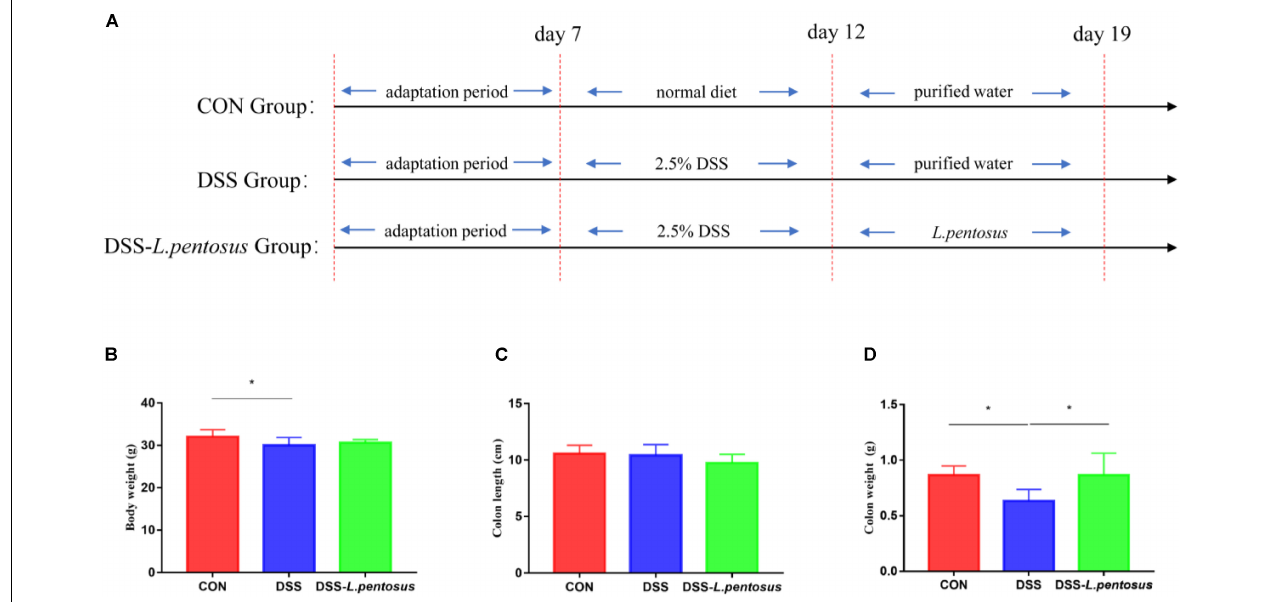
FIGURE 1 | The therapeutic effects of intragastric administration of Lactobacillus pentosus on body weight, colon length, and colon weight. (A) The experimental process; (B) body weight; (C) colon length; (D) colon weight. Data are mean ± SD ( n = 8) and analyzed by one-way ANOVA. * p < 0.05.